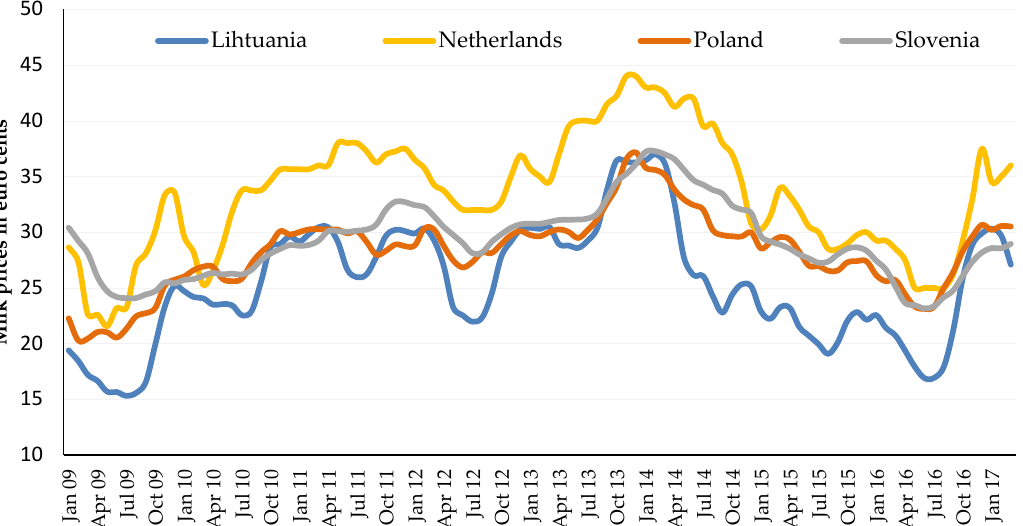
Figure 6. Trend in milk prices in four countries in study. Source: EUROSTAT.